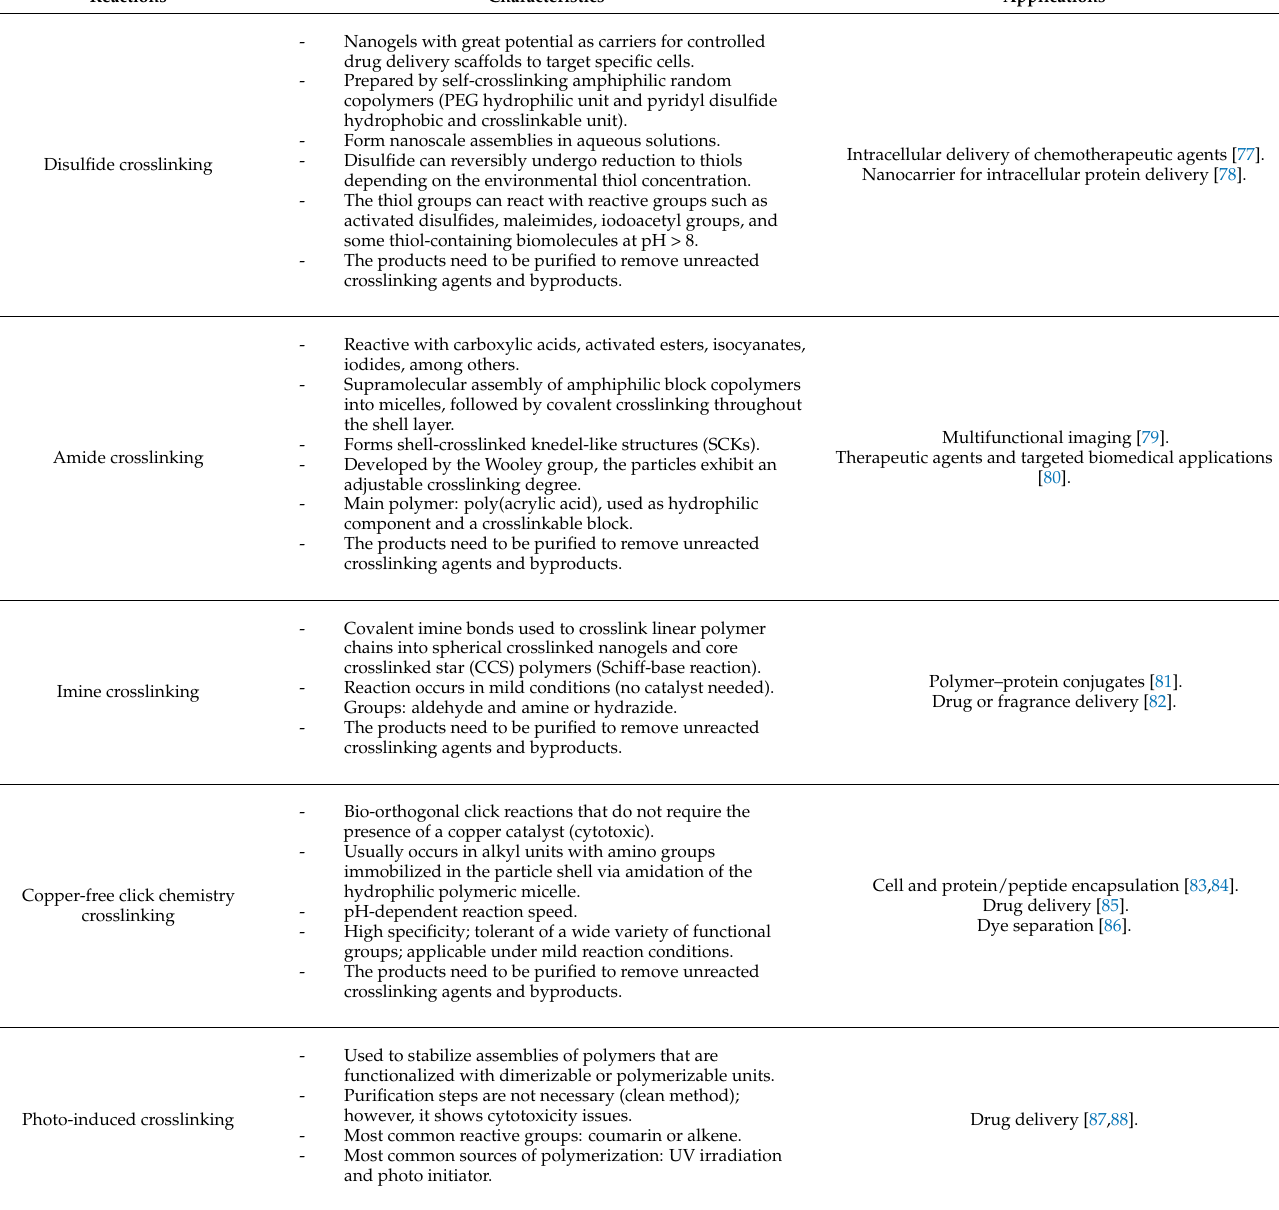
Table 2 lists the main synthesis techniques to produce nanogels from polymer precursors, the main characteristics of the particles and some of their most common applications. Table 2. Crosslinking reactions for the synthesis of nanogels from polymeric precursors. Reactions Characteristics